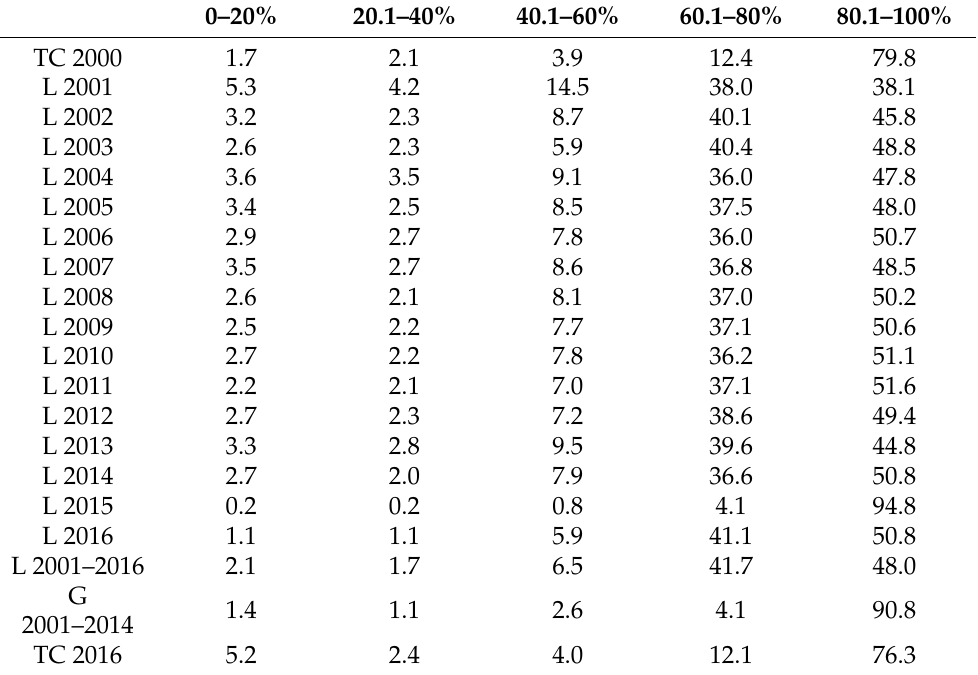
Table 1. Evolution of the forest, loss and gain areas, taking into account the degree of forest coverage per pixel analyzed (as a percentage of total forest, loss and gain areas); L = loss, G = gain, and TC = tree cover